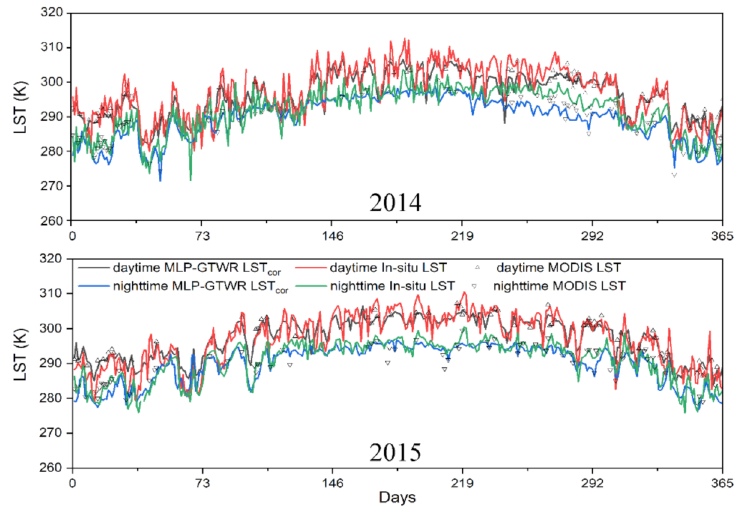
Figure A4. Temporal variations in daytime and nighttime MODIS LST, MLP-GTWR LSTcor, and in-situ measurements at Dinghushan station in the year 2014 ( top ) and 2015 ( bottom